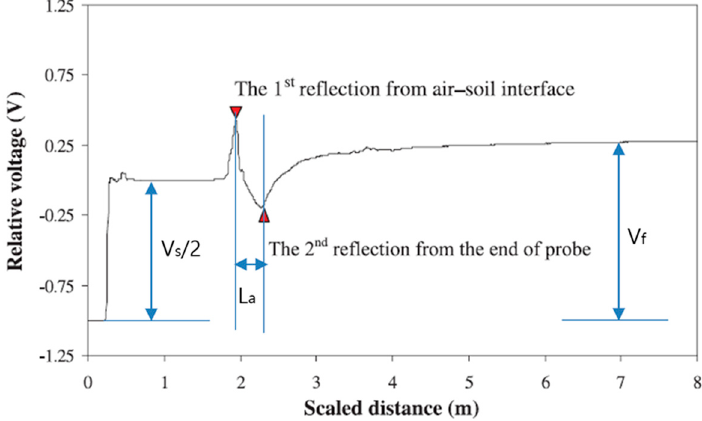
Figure 3. Typical TDR waveform for soil.